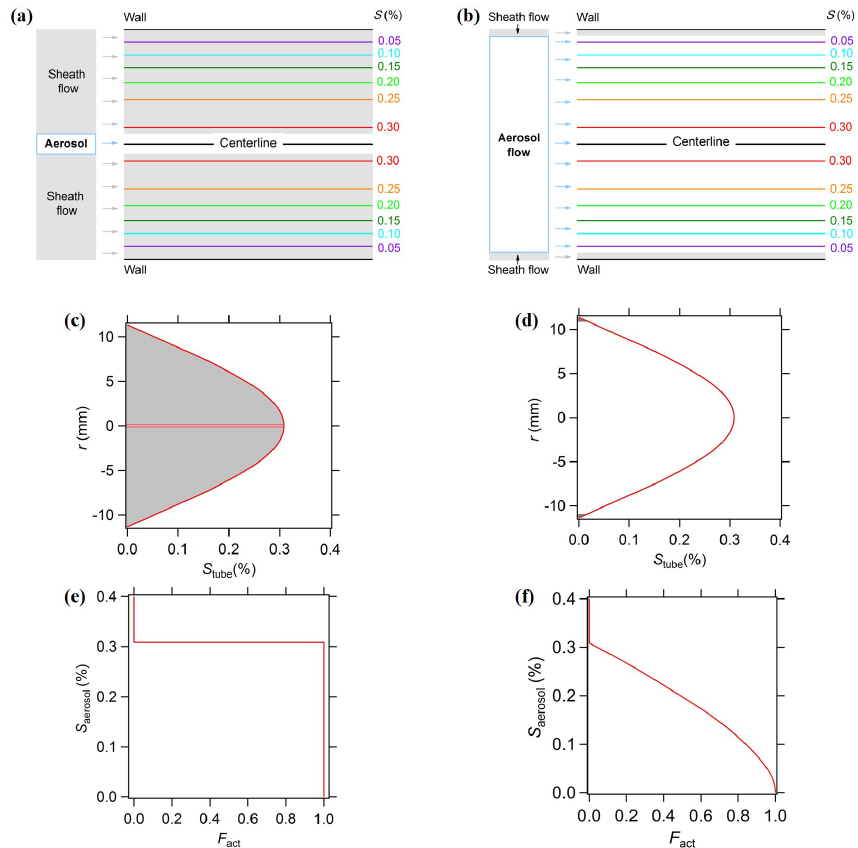
Figure 1. Schematics of typical CCN (a, c, e) and BS2-CCN measurements (b, d, f) . (a, b) Contour of supersaturation in the CCN activation unit and configuration of aerosol and sheath flow; (c, d) distribution of supersaturation in the activation unit ( S tube ). r is the radial distance to the centerline. The shaded areas represent the sheath flow part, and non-shaded areas represent the aerosol flow part. (e, f) Plot of the activation supersaturation of aerosol particles S tube against the activation fraction F act . Reprinted from Su et al. (2016) under the Creative Commons Attribution 4.0 License.